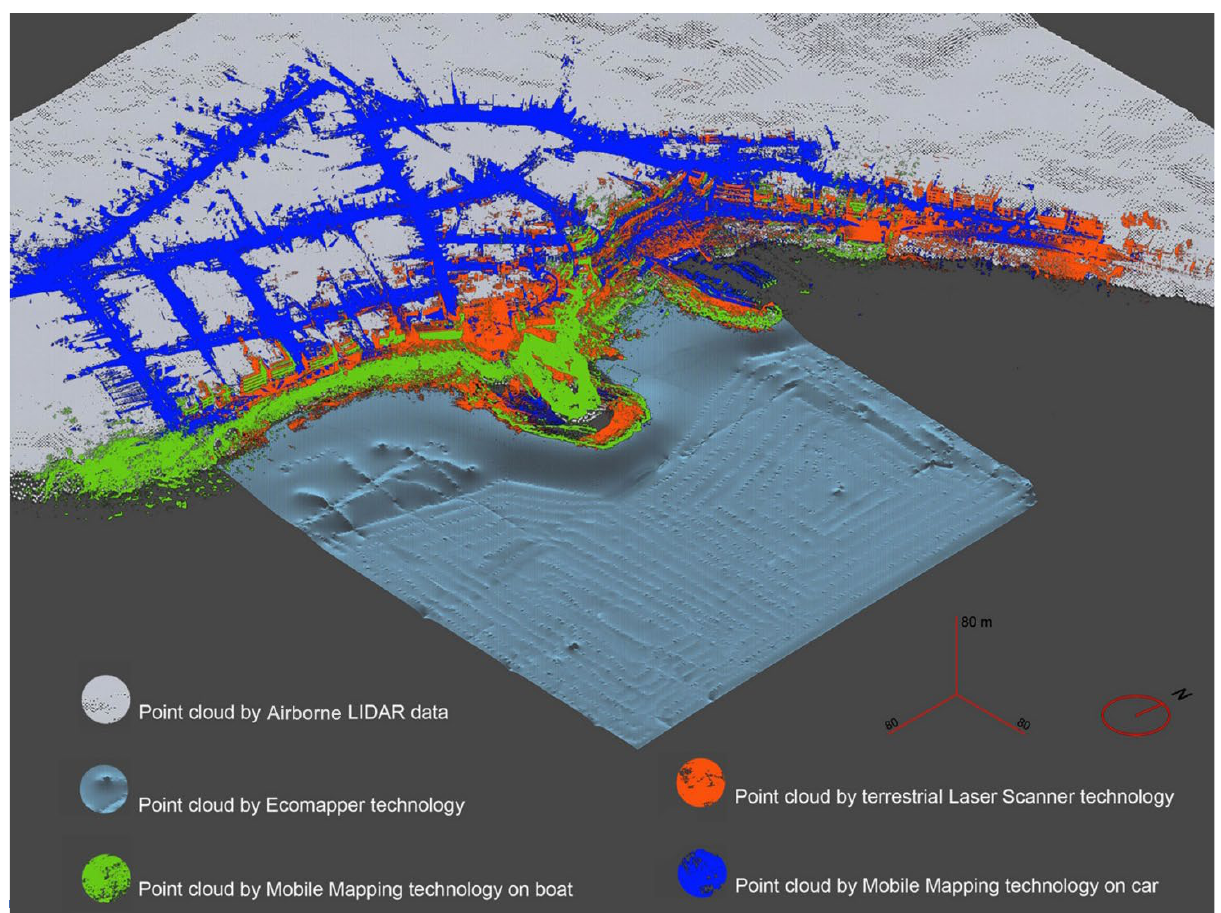
Figure 2: Aci Castello, 3D map of the combined surveying